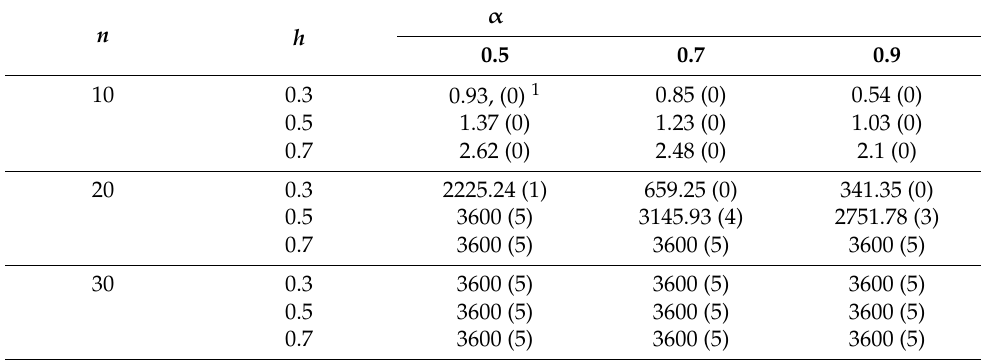
Table 2. Performance of MIP using CPLEX.